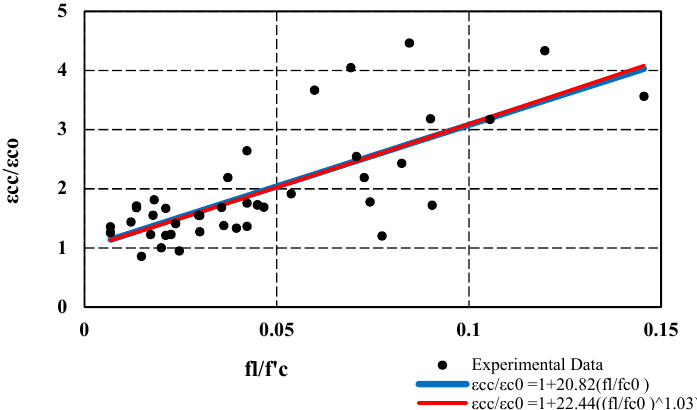
Figure 9. Regression analysis results of Equation (12) and Equation (13).